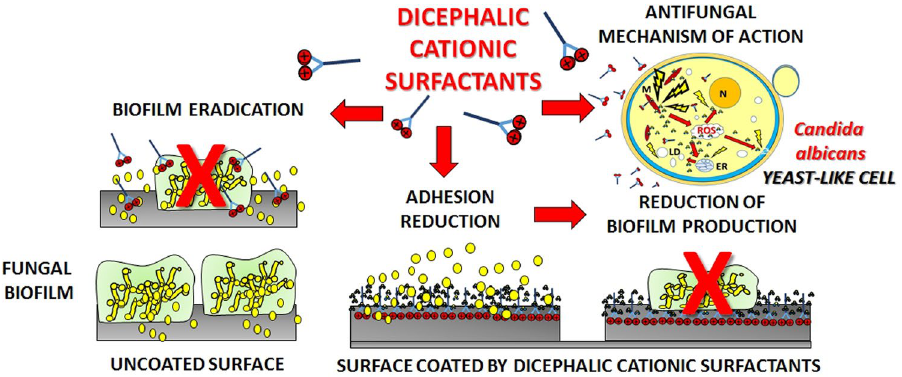
Figure 1. Multifunctional mechanism of action of dicephalic cationic surfactants. Multifunctional mechanism of action of investigated surfactants, taking into account the relation of abiotic surfaces with formation